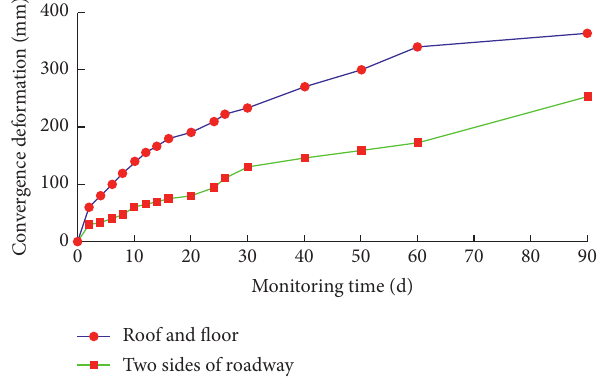
Figure 16: Roadway surrounding rock monitoring